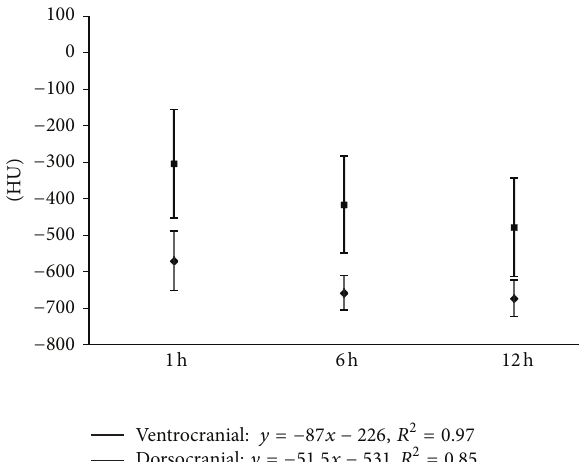
Figure 5: Development of the craniodorsal and cranioventral X- ray absorption values in HE of the subjects in group A ( 𝑛 = 15 ) at the predefined measurement times of the first day of life ( ⬦ = dorsocranial , ◻ = ventrocranial).